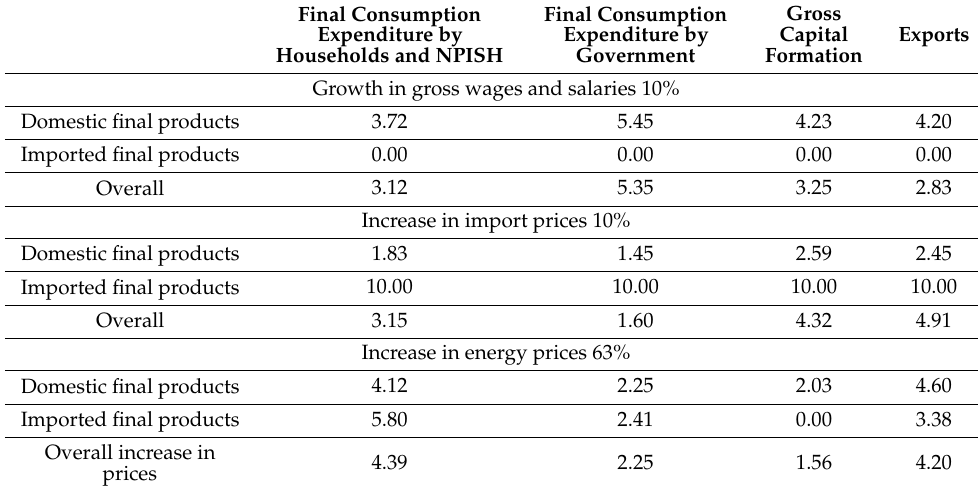
Table 2. Comparison of domestic and import prices for certain categories of final demand in the analyzed scenarios.